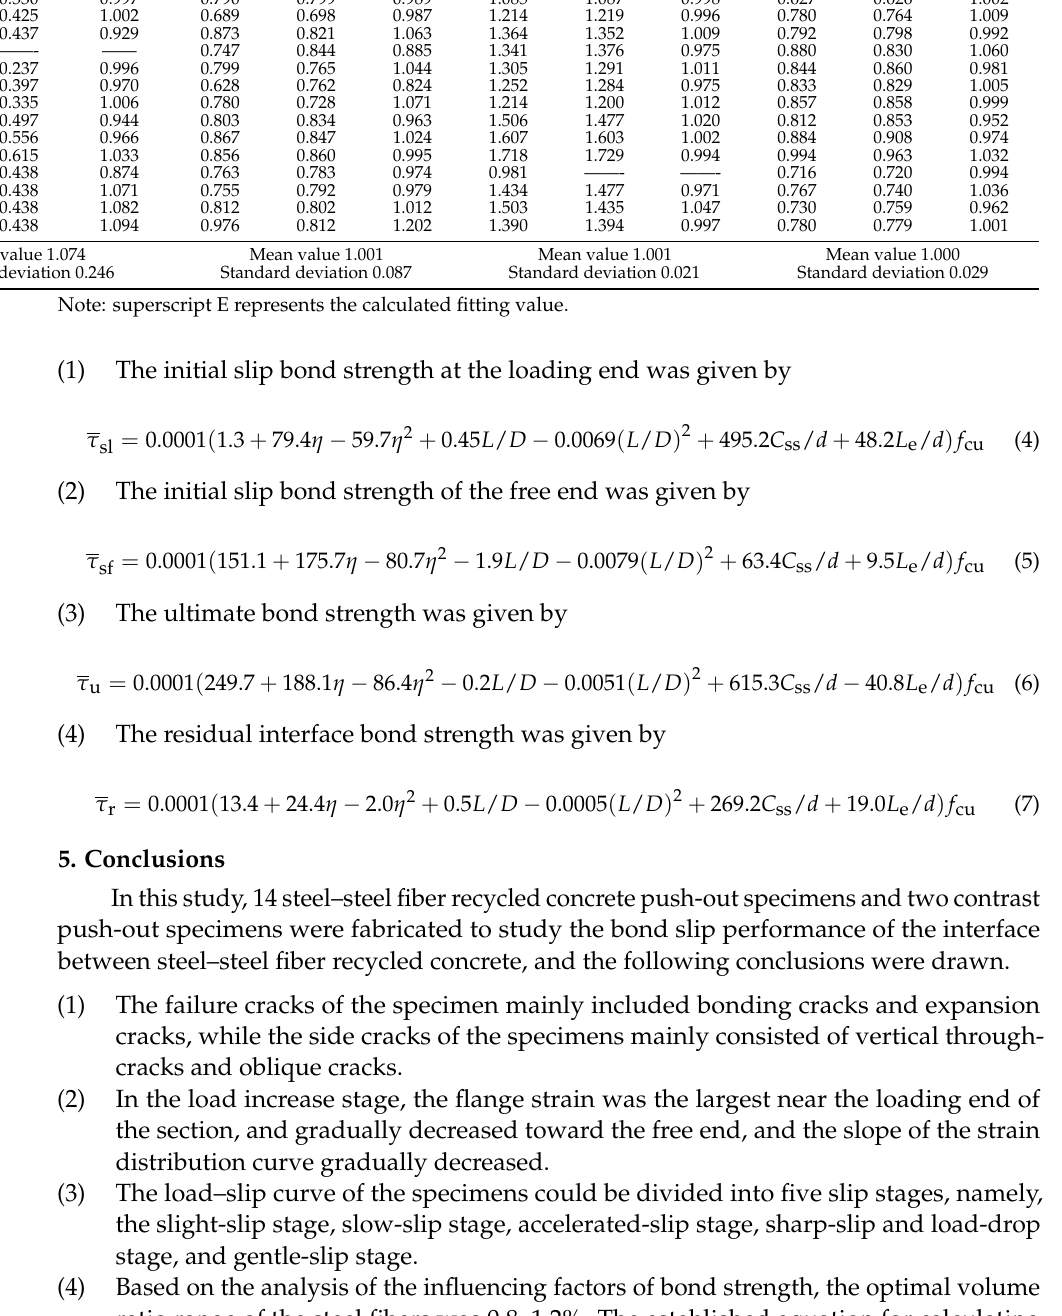
Table 7. The experimental results of the characteristic bond strength compared with the calculated results. Specimen